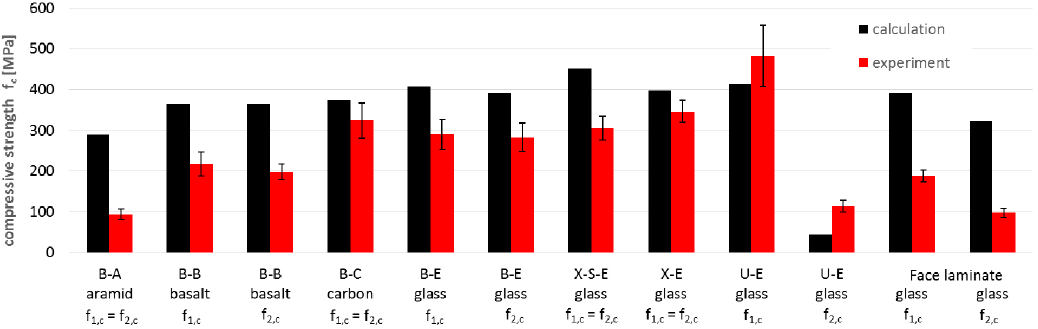
Figure 14. Comparison of compression strength f 1,c and f 2,c obtained by calculation and experiment.